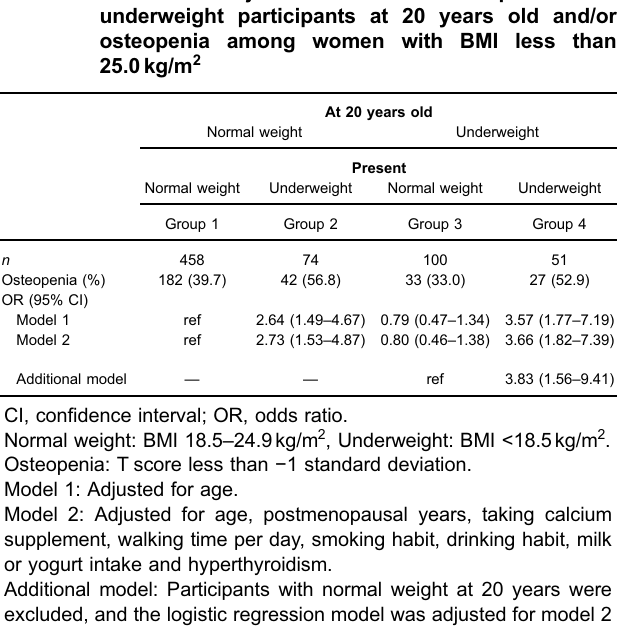
Table 4. Multivariate-adjusted odds ratios of the presence of underweight at 20 years old and/or present for osteopenia At 20 years old Normal or Overweight Underweight Present Normal or Normal or Overweight Underweight